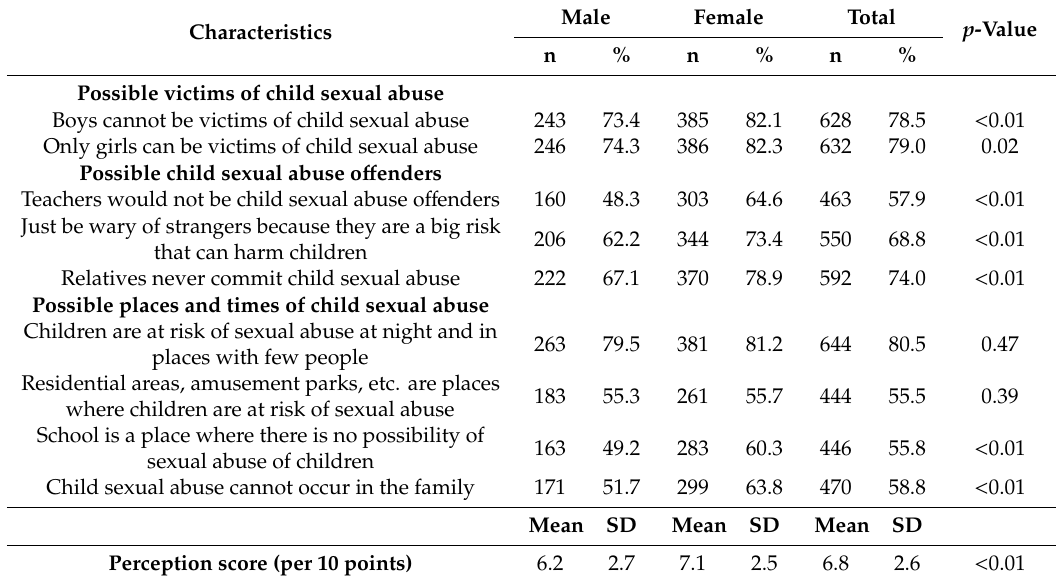
Table 2. Perception of school-age children regarding child sexual abuse (% having “agree” answers). Characteristics